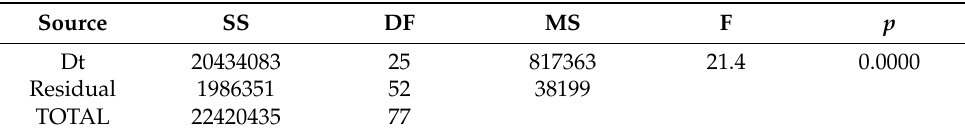
Figure 3. Deployment time. Scallop spat abundances (Individuals/bag), of the three scallop species found, on 8-week-old collectors immersed from June 2013 to July 2014. Table 2. Results of ANOVA, used to test for differences of the spat abundances at all deployment dates (Dt) of collectors immersed for 8 weeks.